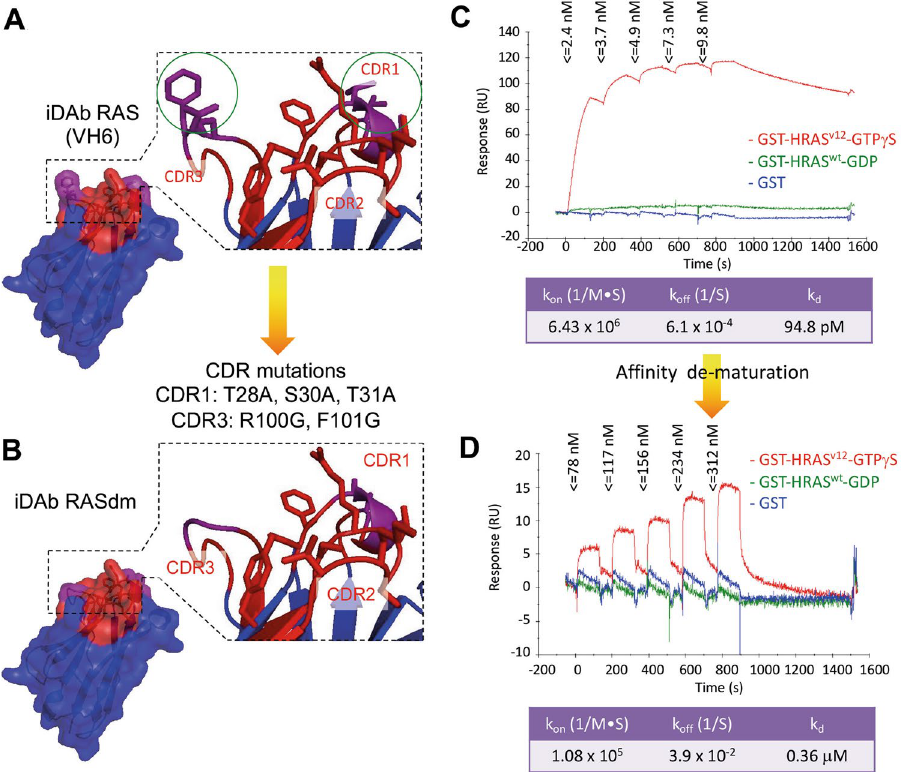
Figure 2. Dematuration of iDAb RAS affinity by mutagenesis of the CDR region. The most critical CDR residues of the anti-RAS iDAb VH6 were determined by the mutagenesis data shown in Fig. 1. Mutation of specific CDR1 and CDR3 residues was used to engineer the dematured iDAb. Panel ( A , B ) show surface representations respectively of unmutated iDAb ( A ) and the engineered iDAb (carrying combined mutations of T28A/S30A/T31A in CDR1 and R100G/F101G in CDR3) ( B ). In each, the CDRs are depicted in red and purple, substituted residues in purple and the framework region in blue. The insets are magnifications of CDRs shown in ribbon form and amino acid residues involved in the binding to RAS are shown in stick configuration. The mutated residues for the engineered iDAb are indicated in green circles in panel ( A ). Panels ( C , D ) show affinity measurement of anti RAS antibody ( C ) and engineered mutant ( D ) with RAS-GTPγS using surface plasmon resonance. The binding kinetics were measured using the intracellular antibody in scFv format, comprising VH6 plus VL204 held by a short linker sequence ( C ) or the mutated iDAb VH6 plus VLI21 3 by single cycle surface plasmon resonance kinetics method on a BIAcore T100. The graphical representations are sensorgrams of the two scFvs with GST (blue sensorgrams), GST-RAS-GDP (green sensorgrams) or GST-RAS-GTPγS (red sensorgrams). The response units were normalized to the response in a channel without captured protein. The tables show values for the association rate (k on M -1 s -1 ), dissociation rate (k off s -1 ), and the equilibrium dissociation constant (K d ) determined with the BIAcore T100 evaluation software